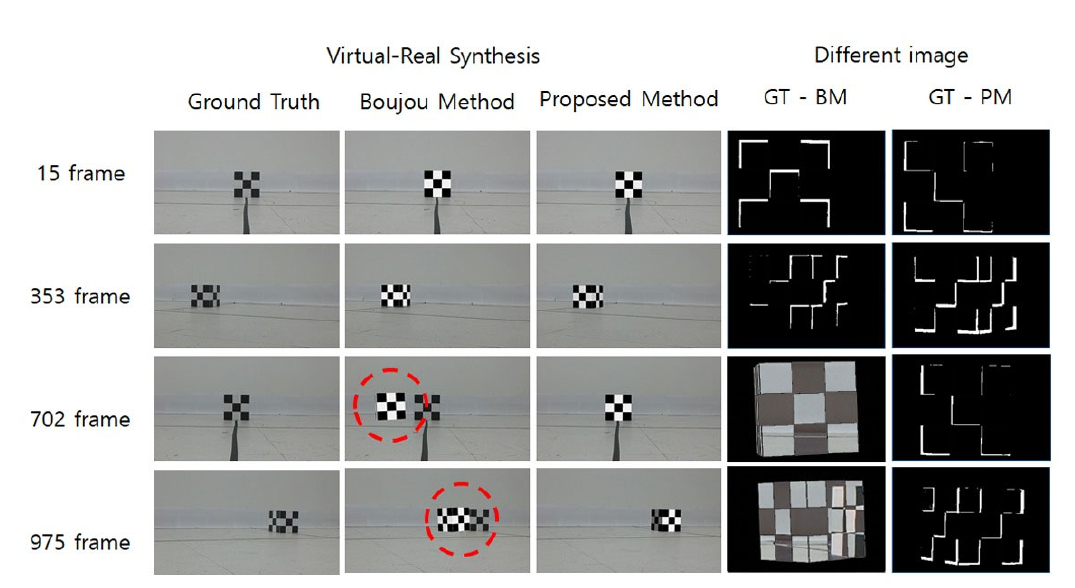
Figure 11. Comparison of different images in match-moving with motion blur. Table 3. Match rate of different images in match-moving with motion